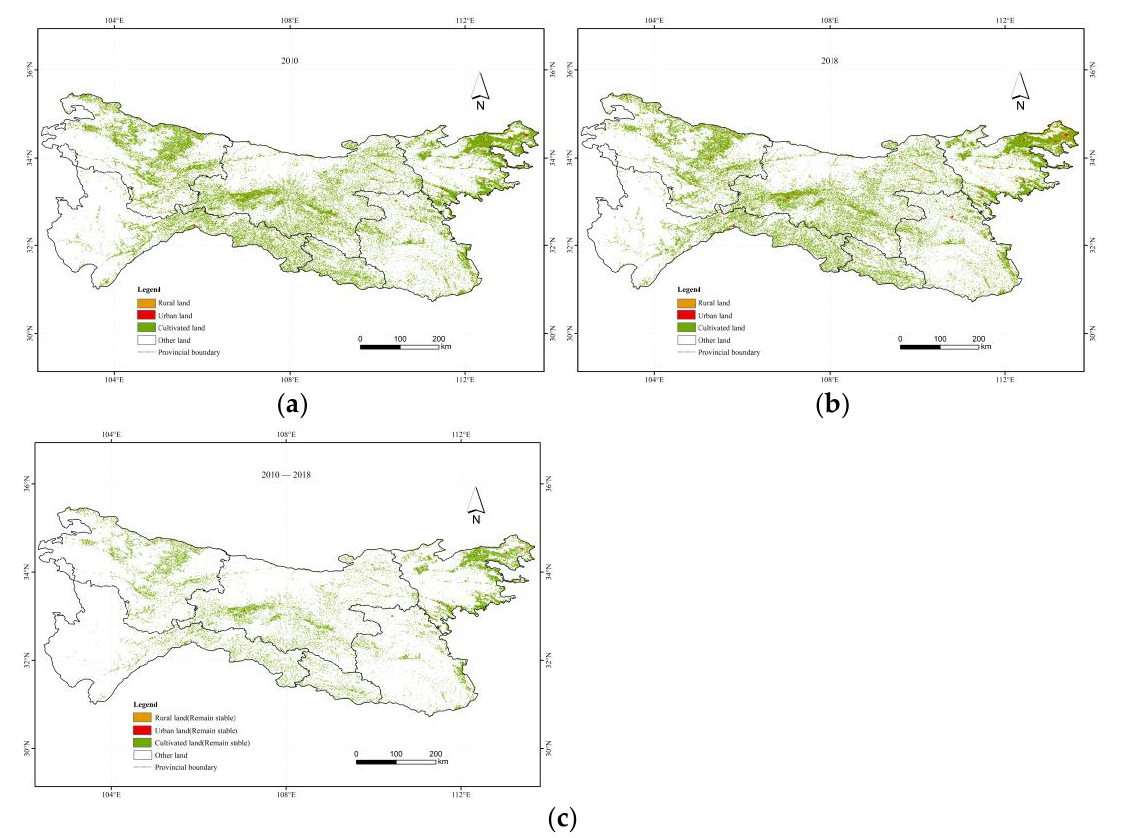
Figure 1. Map showing elevation of the Qinling – Daba mountains.